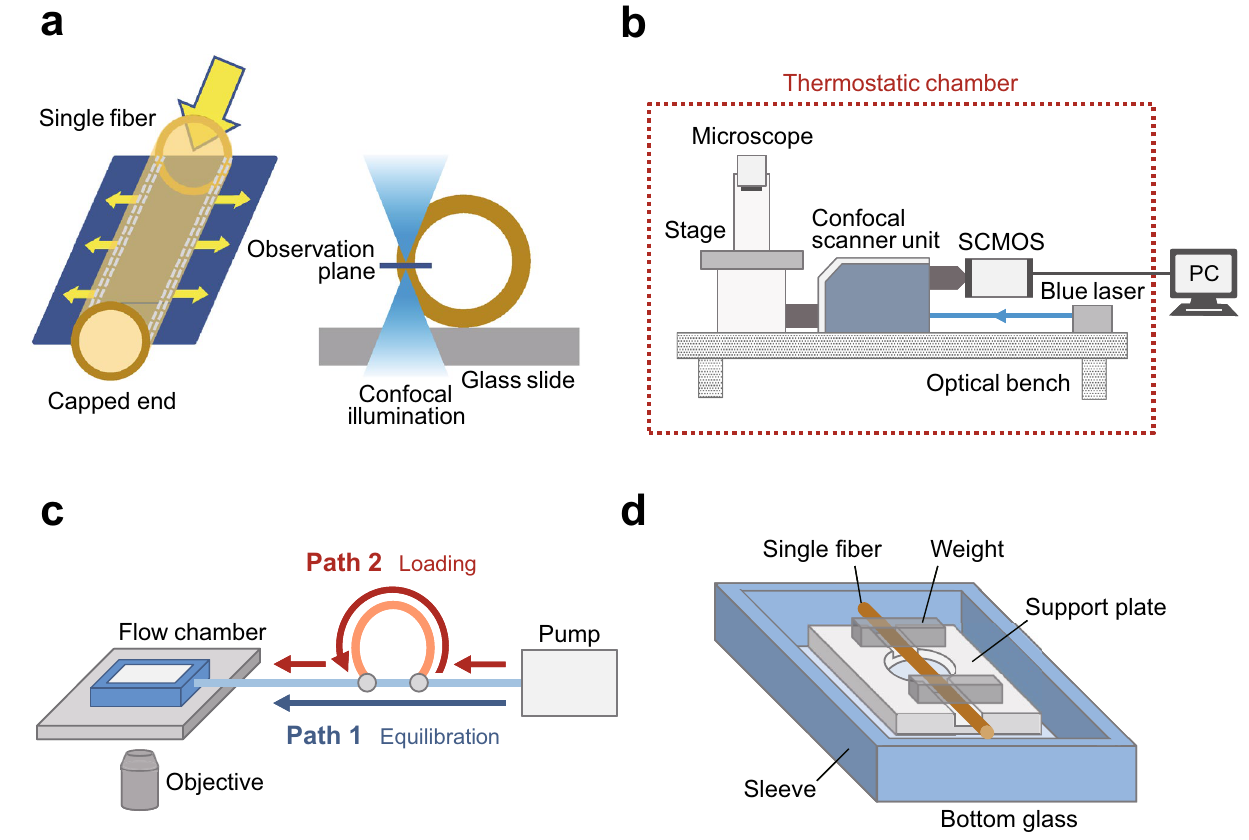
Figure 1. Experimental setup used to visualize biomolecules behavior in single virus removal hollow fiber membrane. ( a ) Schematic of the configuration and flow characteristics of medium through the hollow fiber membrane. ( b ) Diagram of the optical microscope and recording equipment setup. ( c ) Tubing diagram. ( d ) Sample observation